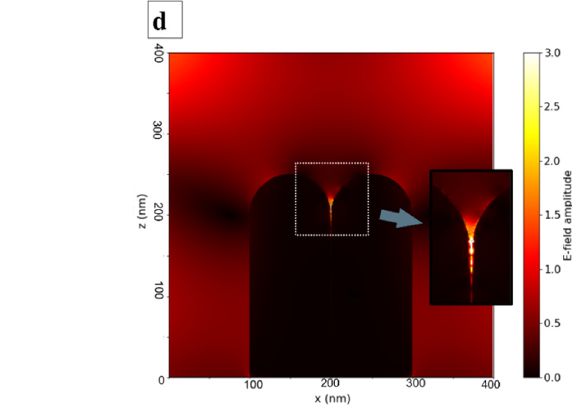
Figure 8. E ‐ field distribution in the nanometric gap between two Ag ‐ NWs for two types of substrates: ( a ) “wet” and ( b ) Figure 8. E-field distribution in the nanometric gap between two Ag-NWs for two types of substrates: ( a ) “wet” and “dry” substrates with “long” Ag ‐ NWs; ( c ) “wet” and ( d ) “dry” substrates with “medium ‐ sized” Ag ‐ NWs. ( b ) “dry” substrates with “long” Ag-NWs; ( c ) “wet” and ( d ) “dry” substrates with “medium-sized”